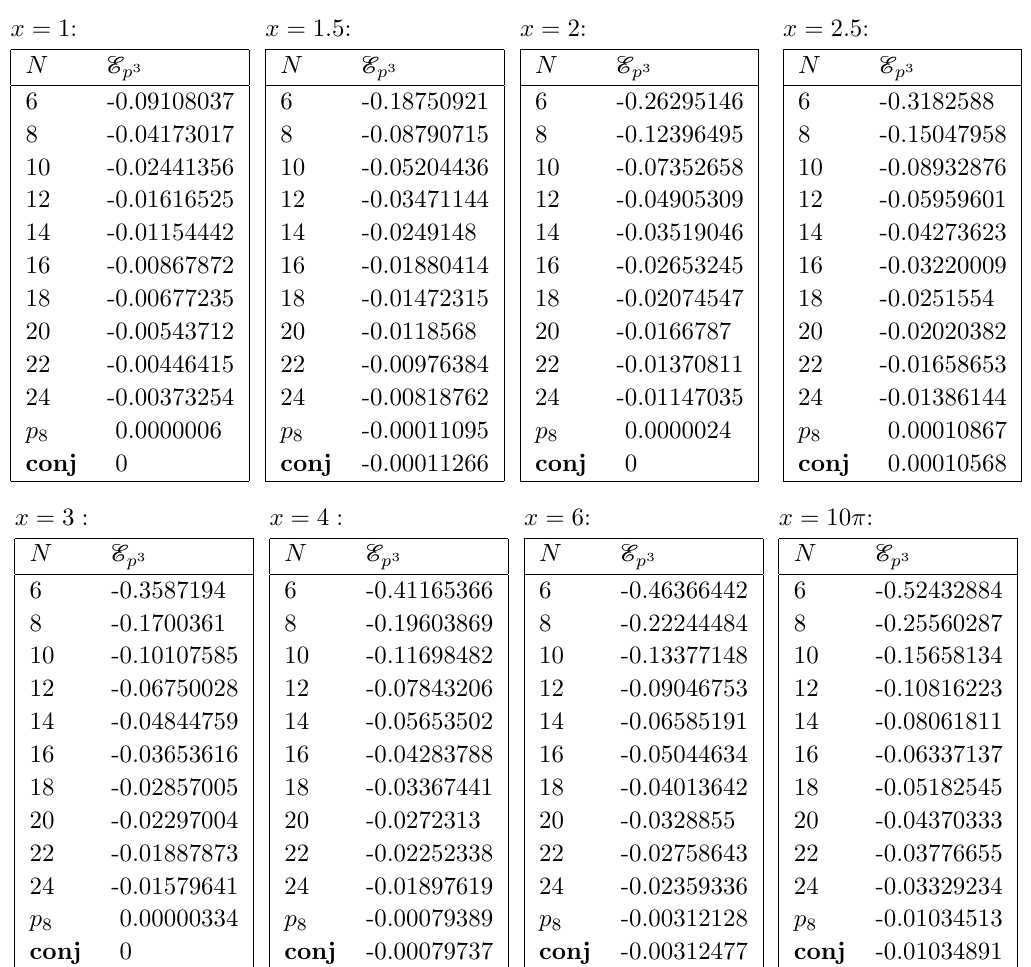
Table 2 . Comparison of the numerical measures for E , de(cid:12)ned in (7.17a), and its conjectured p 3 value which is the right-hand side of (7.19). The agreement between the extrapolated values and the conjecture is seen to be excellent, with a precision of the order 10 (cid:0) 6 for all values of x . The same conventions as in table 1 are used for the extrapolated values p 8